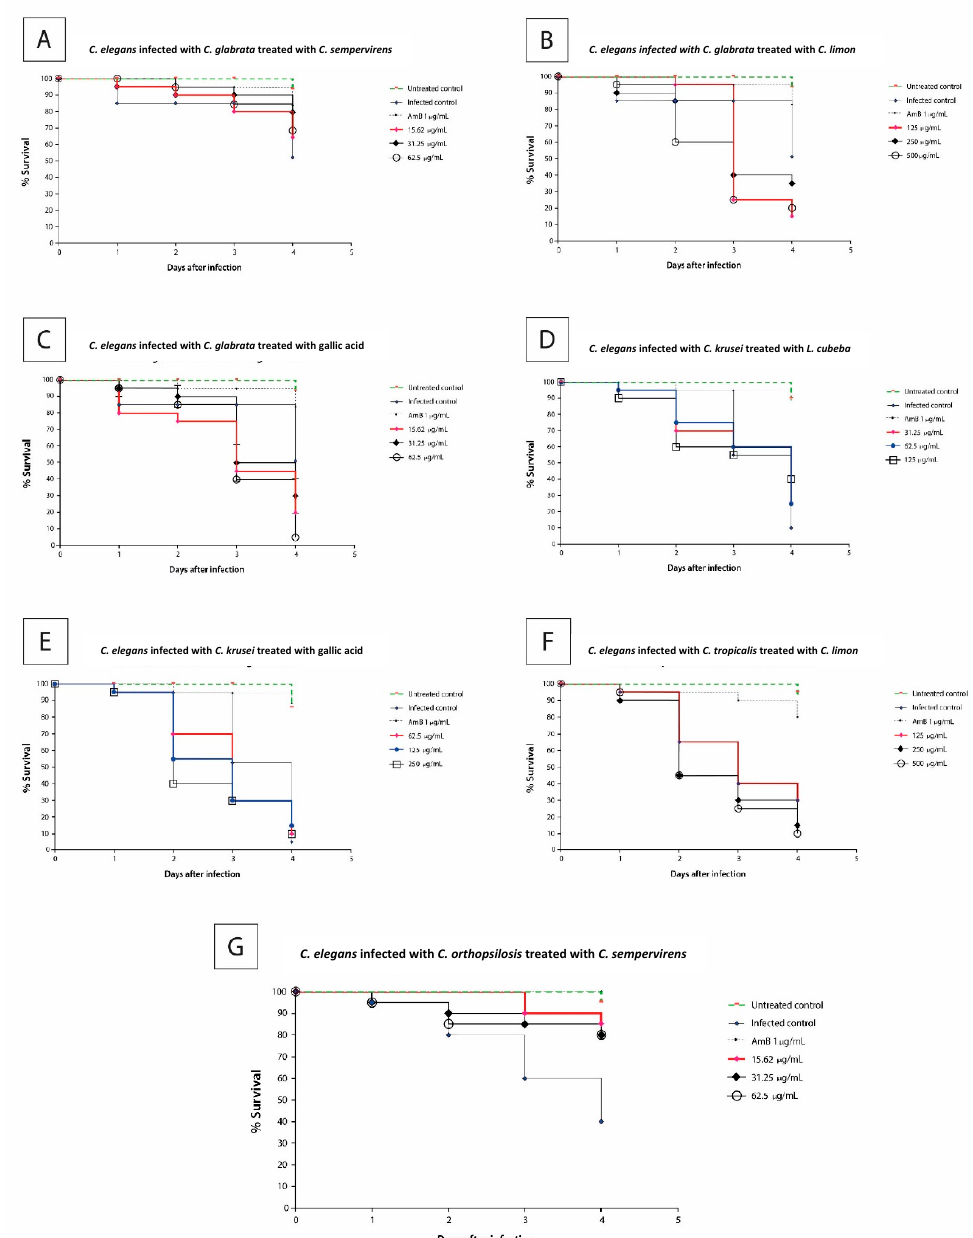
Figure 2. Survival curves of the responses to the tested compound concentrations from the Caenorhabditis elegans–Candida infected model. Nematode survival diminished at 0.5 × MIC, 1 × MIC, and 2 × MIC for all the compounds, except for the Cupressus sempervirens EO. ( A )— C. elegans infected with C. glabrata and treated with C. sempervirens EO, ( B )— C. elegans infected with C. glabrata and treated with C. limon EO, ( C )— C. elegans infected with C. glabrata and treated with gallic acid, ( D )— C. elegans infected with C. krusei and treated with L. cubeba EO, ( E )— C. elegans infected with C. krusei and treated with gallic acid, ( F )— C. elegans infected with C. tropicalis and treated with C. limon, ( G )— C. elegans infected with C. orthopsilosis and treated with C. sempervirens . The untreated control group is represented by the green lines; the infected control, the fungicidal control drug (amphotericin B ), and the different concentrations of the tested compounds are represented by symbols. The results were obtained from three independent experiments with at least three replicates.